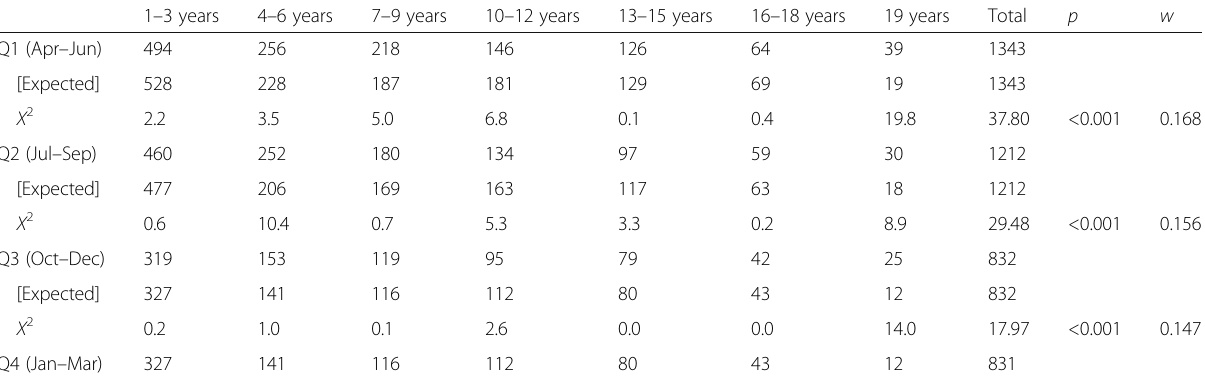
Table 3 Number of players grouped by 3 years for lengths of professional